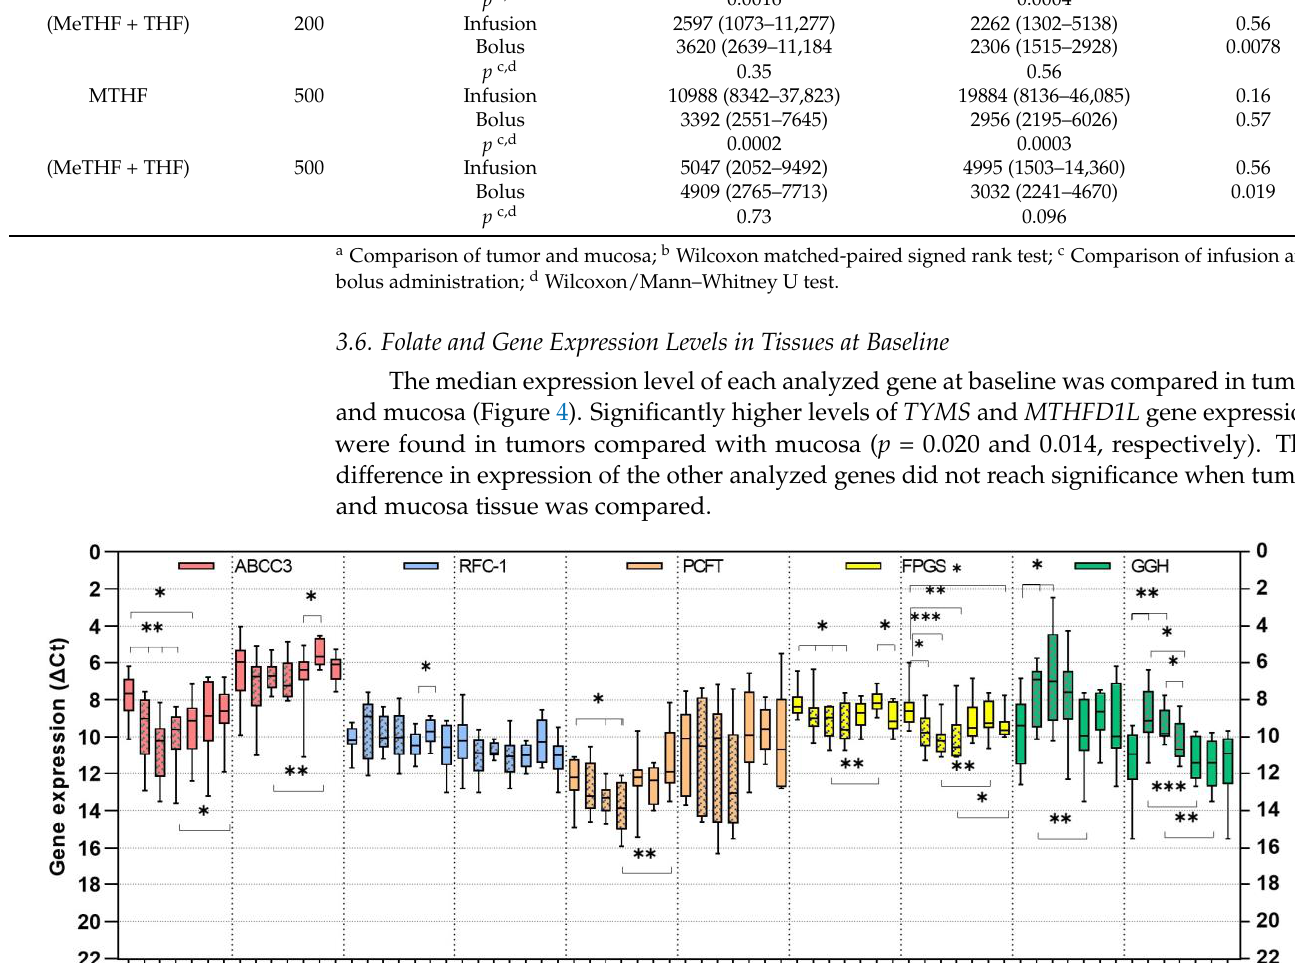
Figure 4. Box plots showing median gene expression levels in tumors (t) and mucosa (m) of colon cancer patients at baseline (0, n = 10) and after administration of 60 mg/m 2 (Inf n = 10, Bol n = 10), 200 mg/m 2 (Inf n = 10, Bol n = 8), or 500 mg/m 2 (Inf n = 10, Bol n = 10) LV administered as two-hour infusion (Inf, shaded boxes) or bolus (Bol) injections. Significance asterisks above boxes show dif- ferences in tumors or mucosa related to LV dosage whereas significance asterisks below boxes show differences in tumors or mucosa relating to LV administration (two-hour infusion or bolus injection) at a specific LV dosage. * p  0.05; ** p  0.01, *** p  0.001. 3.7. Gene Expression Alterations in Tumor and Mucosa at Increasing Dosage of LV To establish if the LV dosage influence folate levels by altering the expression of fo- late-associated genes, the gene expression levels were determined in tumor and mucosa of patients treated with increasing LV dosages and compared with baseline levels. The median ABCC3 and PCFT expression was significantly lower in tumors compared to mu- cosa after two-hour infusion as well as bolus injection of LV (Figure 4). It was noted that the expression pattern of ABBC3 and PCFT was synchronized after LV administration in both tumor and mucosa. With exception of SHMT1 , all other genes had a higher expres- sion in tumors compared to mucosa. Compared to baseline, ABCC3 and FPGS expression in tumors was lower at all dosages after two-hour infusion whereas PCFT expression was lower at 200 and 500 mg/m 2 and GGH expression higher at 60 and 200 mg/m 2 . No signifi- cant differences were found when baseline expression levels in tumors were compared with levels after bolus injection of LV. In mucosa, the major differences in gene expression were lower FPGS and higher GGH gene expression after two-hour infusion compared to bolus injection and baseline. Furthermore, the expression of TYMS , MTHFS , and MTHFD2 was higher after two-hour infusion compared to baseline or bolus administration. It was also noted that the expres- sion of GGH , TYMS , MTHFS , and MTHFD2 in mucosa after two-hour infusion of LV fol- lowed the same pattern with the highest level at 60 mg/m 2 and the lowest at 500 mg/m 2 .